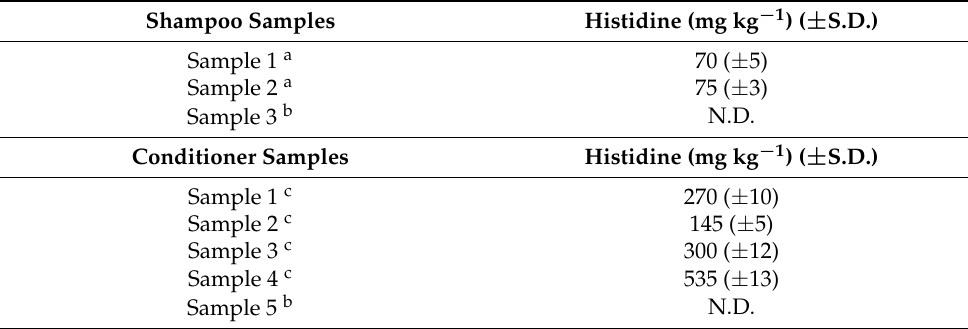
Table 3. Histidine content in shampoo and conditioner products ( n = 3).